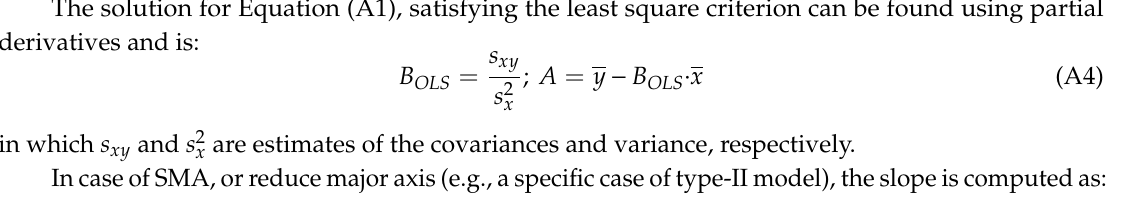
Figure A1. For an OLS line, the error is defined as the vertical dispersion of a point from the straight line (distance 1 to 2) and the quantity minimized is the sum of squares of these linear distances. In case of SMA, on the other hand, the error is defined as the area of the triangle 3-4-5 and the quantity minimized is the sum of these area (redrawn from Smith et al., 2009 [30]) ( a ). Scatter plot and linear fits calculated with OLS (blue) and SMA (red) methods by using a syntehtical datasets with a normal distributed error added to both X and Y variables ( b ).